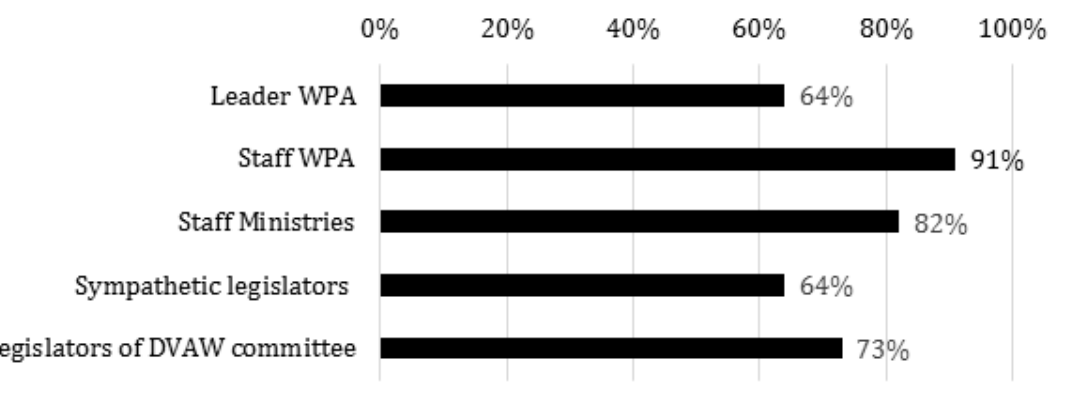
Figure 2: Mechanisms used to in(cid:976)luence the political sphere in Brazil